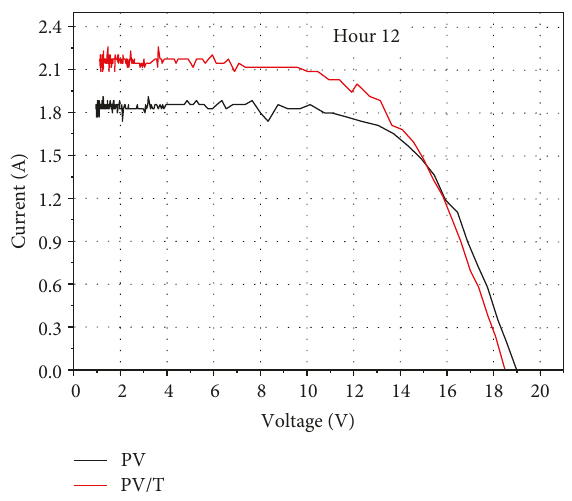
Figure 10: Current-voltage characteristic curves of the PV/T air collector and PV module.